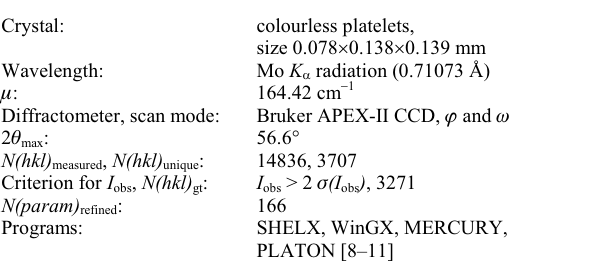
Table 1. Data collection and